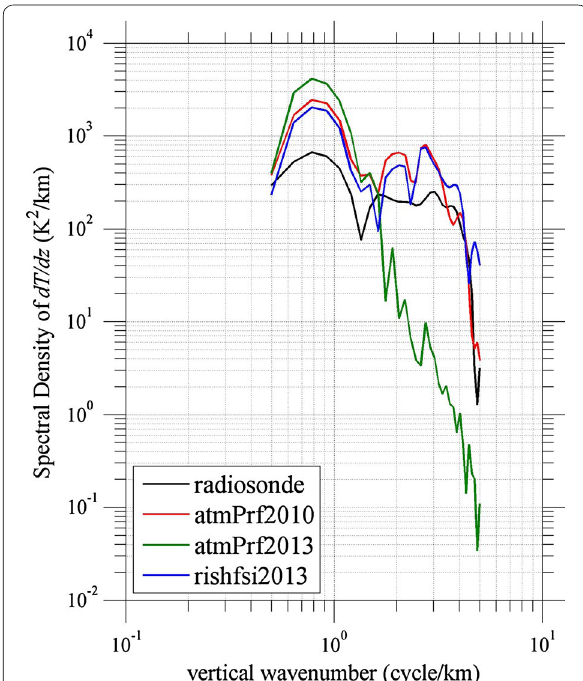
Fig. 13 Vertical wave number spectra of the d T /d z profile in Fig.